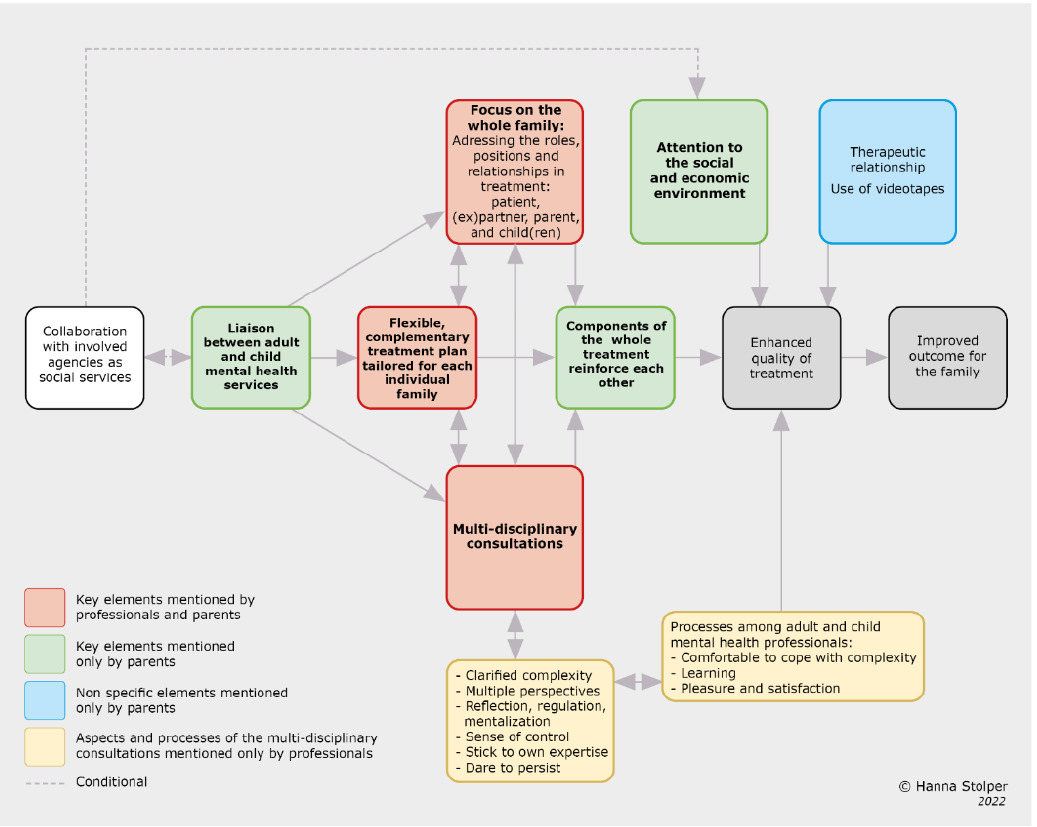
Figure 1. Model of an integrated family approach in mental health care according to professionals and parents.